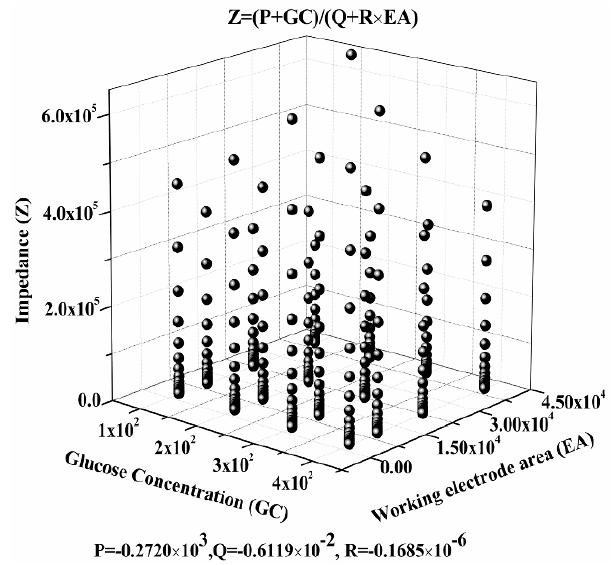
Fig. 8: Dependence plot of impedance with respect to working electrode area and glucose